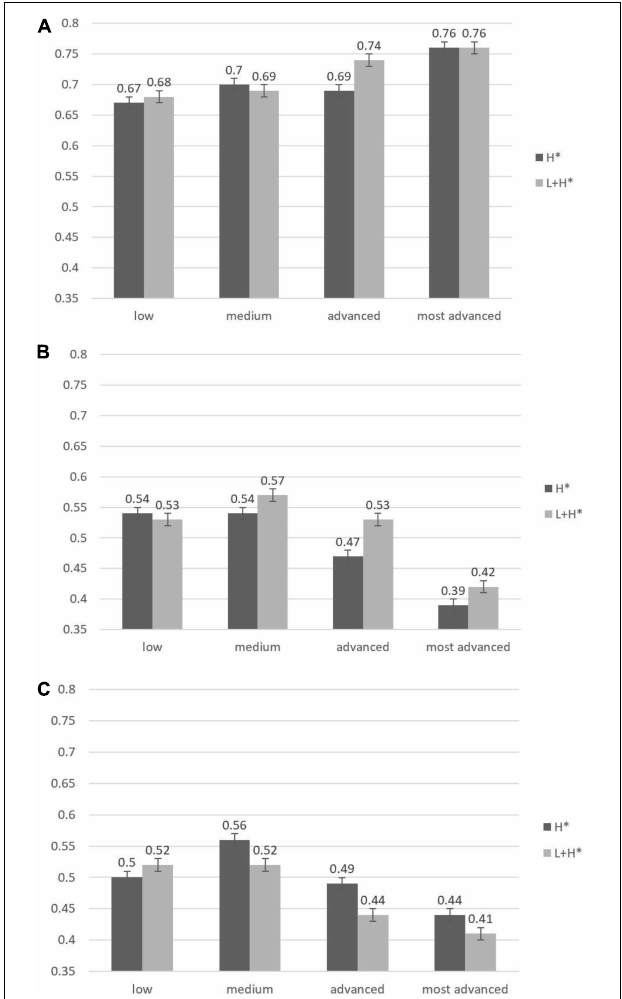
FIGURE 1 | Bar charts of proportions of true responses across groups and conditions. (Note that true is a correct response to correct probes, but an incorrect response to contrast and unmentioned probes). (A) Correct probes. (B) Contrast-probes. (C) Unmentioned probes. *stands for the